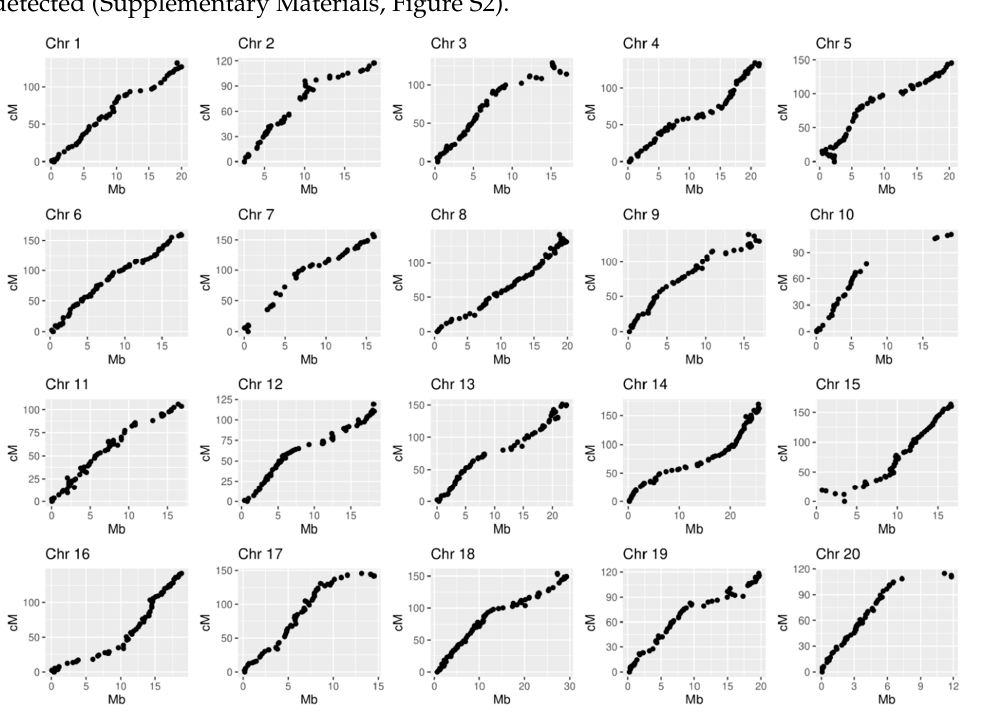
Figure 4. Collinearity revealed between the genetic distances on the M. rotundifolia ‘Dixie’ (cM) linkage map and the physical position (Mb) of the SNP in the M. rotundifolia cv. ‘Noble’ genome. 2.5. Assessment of the ‘Dixie’ S1 Population for Resistance to Powdery and Downy Mildew and the Variation of Morphological Traits Combining a high-density linkage map generated using an M. rotundifolia cv. Dixie S1 population and field evaluation data, we attempted to find loci affecting valuable agro- biological traits of this muscadine vine, which can be revealed by their segregation in the ‘Dixie’ S1 progeny. First, the established S1 mapping population of M. rotundifolia cv. Dixie was evalu- ated for resistance to powdery mildew (oidium, Erysiphe necator ) and downy mildew ( Plasmopara viticola ) in a laboratory experiment. Fragments of shoots with three leaves were artificially infected with an aqueous suspension of oidium conidia washed off from infected grapes collected on the southern coast of Crimea. Additionally, a dry powder of oidium conidia was applied to infect the leaves. Inoculated leaves were scored for the general level of resistance (OIV452) three, seven, ten, and fourteen days post-inoculation, and no signs of infection were detected. Similarly, in experiments with the artificial treatment of ‘Dixie’ S1 progeny with downy mildew conidia (see Methods), no infection was observed three, seven, ten, and fourteen days after inoculation. In the field, we also did not observe signs of infection with mildew and oidium on ‘Dixie’ seedlings. Thus, we concluded that ‘Dixie’ muscadine may have homozygous non-segregating loci conferring complete resistance to the fungal path- ogens. Given the significant variation of the ‘Dixie’ S1 seedlings by their ability to overcome winter frosts and successfully survive in a new stressful environment, we evaluated a